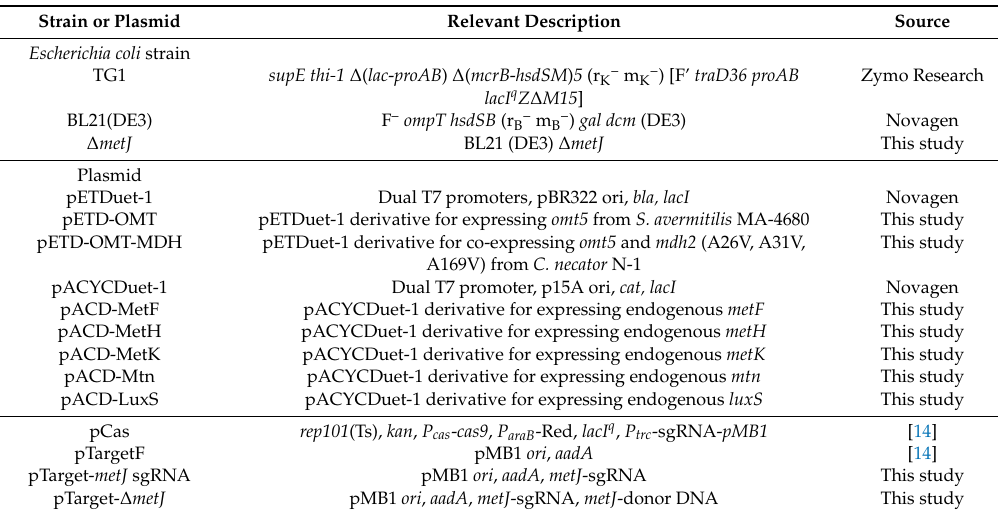
Table 1. Strains and plasmids used in this